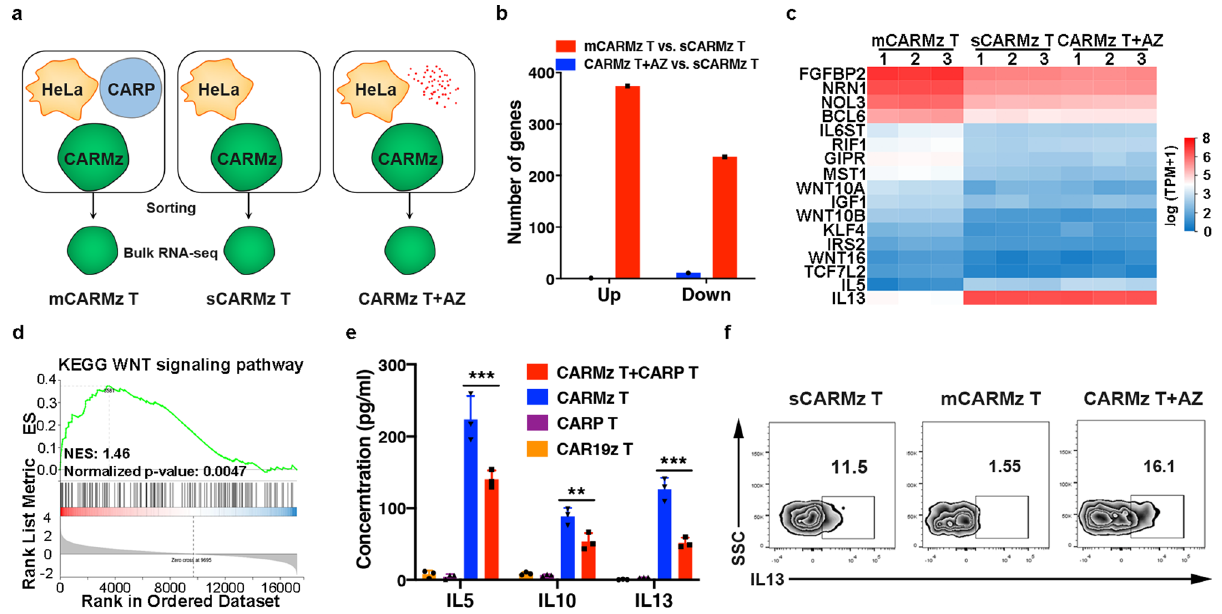
Fig.3|BulkRNA-seqanalysisofindividualCARMzT(sCARMzT),CARMzTfrom amixtureofCARMzTandCARPT(mCARMzT)andCARMzTcellstreatedwith anti-PD-L1 mAb (CARMz T+AZ) after coculture with HeLa-GL cells. a – d Bulk RNA-seq strategy: individual CARMz T (sCARMz T), CARMz T from a mixture of CARMz T and CARP T (mCARMz T) and CARMz T cells treated with AZ (20 μ g/ml) (CARMz T+AZ) were isolated by fl ow cytometry sorting based on their GFP tag post-coculturewithHeLa-GLcells,andthenperformedbulkRNA-seqanalysis( N =3 biological samples). The red dots represent AZ. b The numbers of genes upregu- latedanddownregulatedinCARMzT+AZandmCARMzTcomparedwithsCARMz T. c The heatmap shows clustering of differential expressed genes (DEGs) in sCARMz T, mCARMz T, and CARMz T+AZ ( N =3 biological samples). Cutoff: absolute log2 (fold change) ≥ 1; adjusted P value ≤ 0.05. d GSEA illustrating